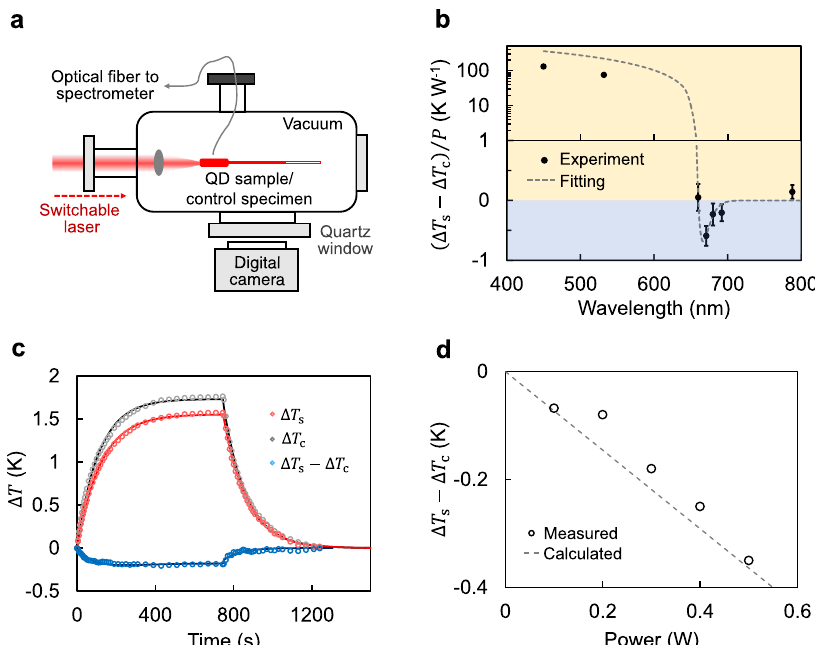
Fig. 4 Optical cooling effects. a Schematic diagram of the setup for optical cooling measurements. Temperature change of QD solution or control specimen in capillary tube under laser irradiation is determined by the volume change of the solution. b Relative temperature changes of the QD sample compared with the control specimen under different excitation wavelengths with unit excitation power (black dots). Error bars represent standard deviation based on three parallel tests. Dashed curve is a fi tting according to our theoretical model (Eq. S31 in the Supplementary Information). The temperature changes are measured at equilibrium-states. c Temperature change kinetics of QD sample (red dots, Δ T s ), control specimen (grey dots, Δ T c ) and their difference (blue dots, Δ T s (cid:1) Δ T c ) measured at 671 nm. Solid lines are single exponential fi ttings (Eq. S22 and S23 in the Supplementary Information). d Excitation power dependent relative temperature change, measured at 671 nm and equilibrium-states. Calculated result (Eq. S31 in the Supplementary Information) is shown as dashed